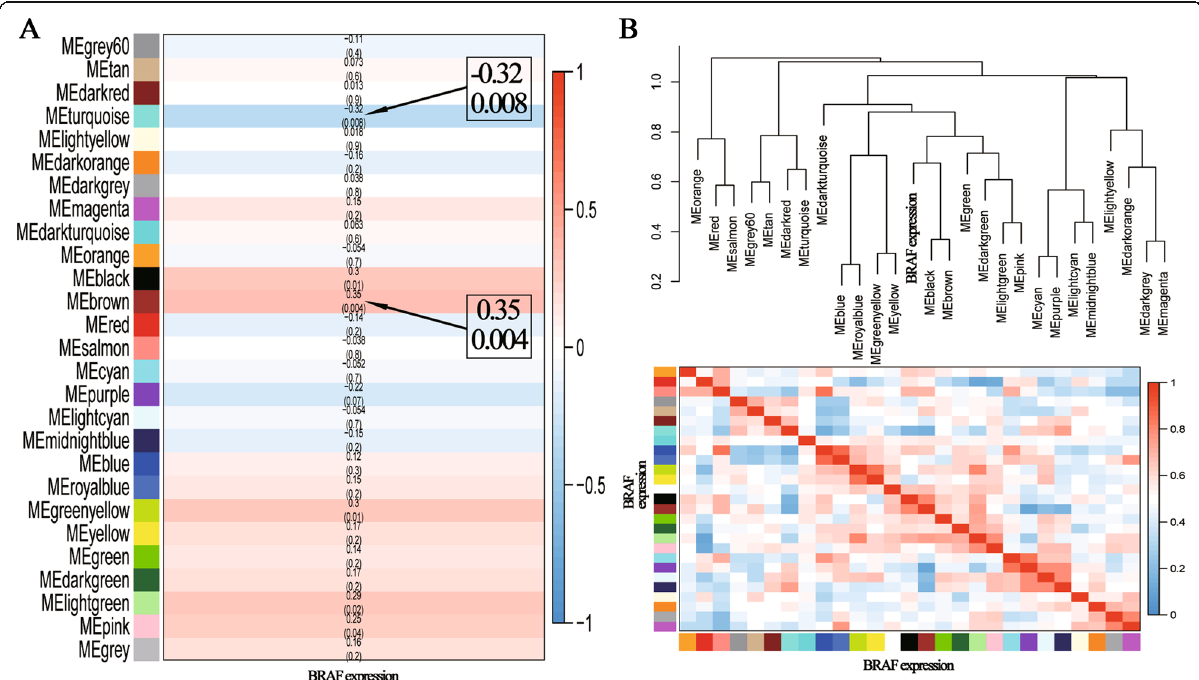
Fig. 4 a Heatmap of module-trait relationships. The brown module was the most positive module (correlation coefficients: 0.35, and p -value: 0.004) correlated with the expression of BRAF , and the turquoise was the most negative module (correlation coefficients: − 0.32, and p -value: 0.008). b Hierarchical clustering of module and heatmap plot of the eigengene adjacencies